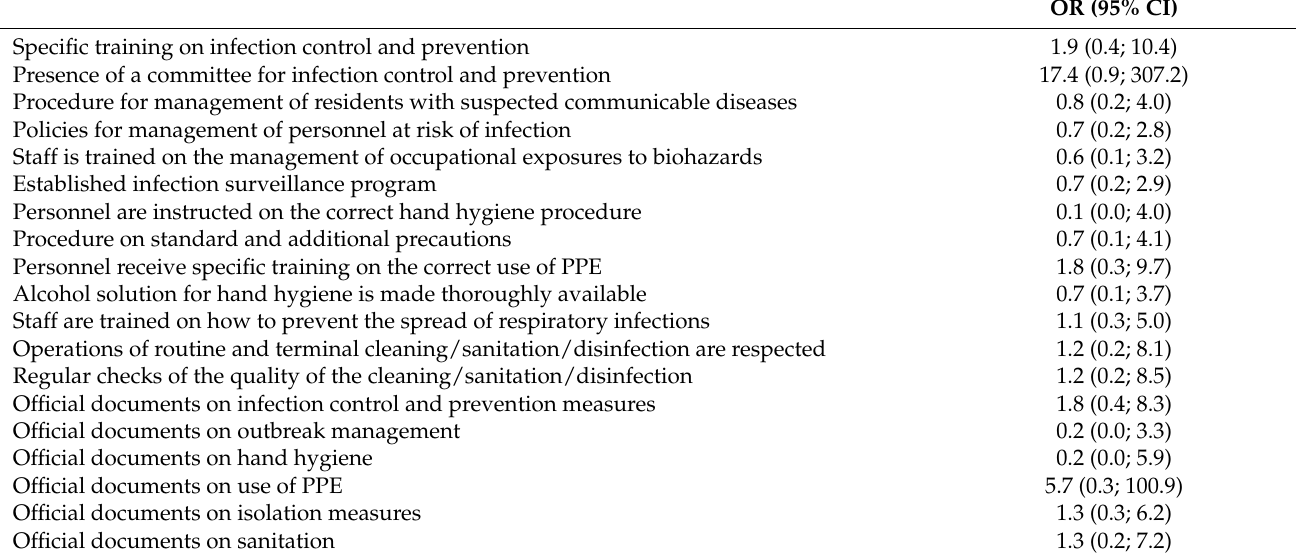
Table A3. Odds Ratio with 95% CIs for the association between being a case of COVID-19 (dependent variable) with measures of infection prevention and control, adjusted for geographical